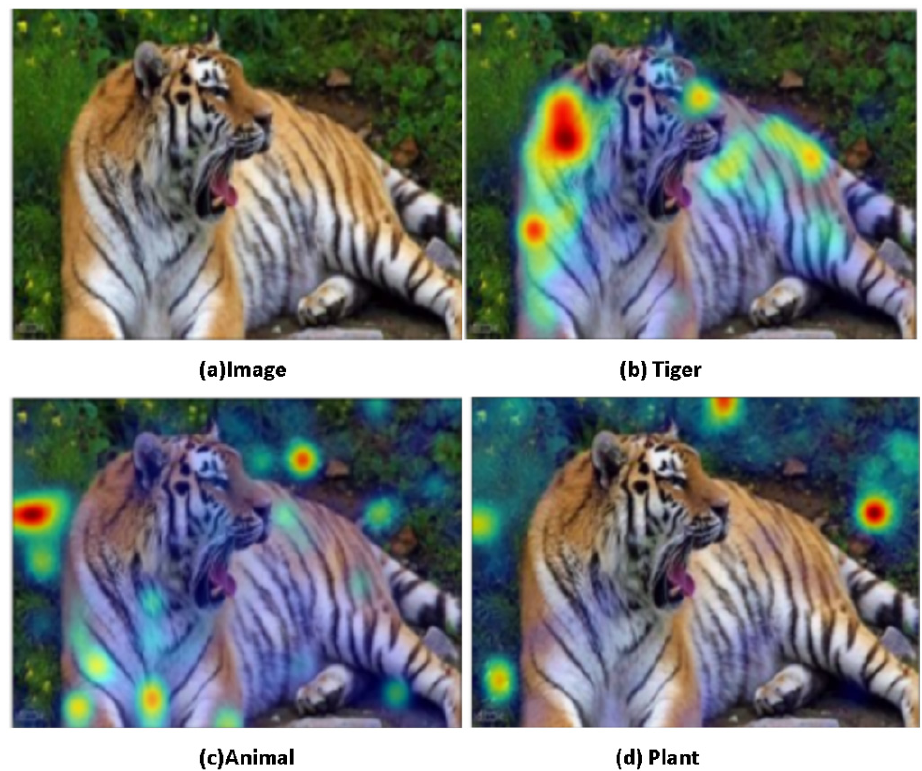
Figure 5. ( a ) is the original image of object detection verification, while ( b – d ) are the object detection heatmaps when the words “tiger”, “animal”, and “plant” are entered. ( b ) is the heat distribution map of the region of interest for the detection of the word “tiger”, ( c ) is the heat distribution map of the region of interest for the detection of the word “animal”, and ( d ) is the detection of the word “plant”. According to the verification results, this model already has the ability to analyze and reason. Not only can our model detect the tiger as the area of interest, but it can also recognize that the tiger is an animal, rather than a